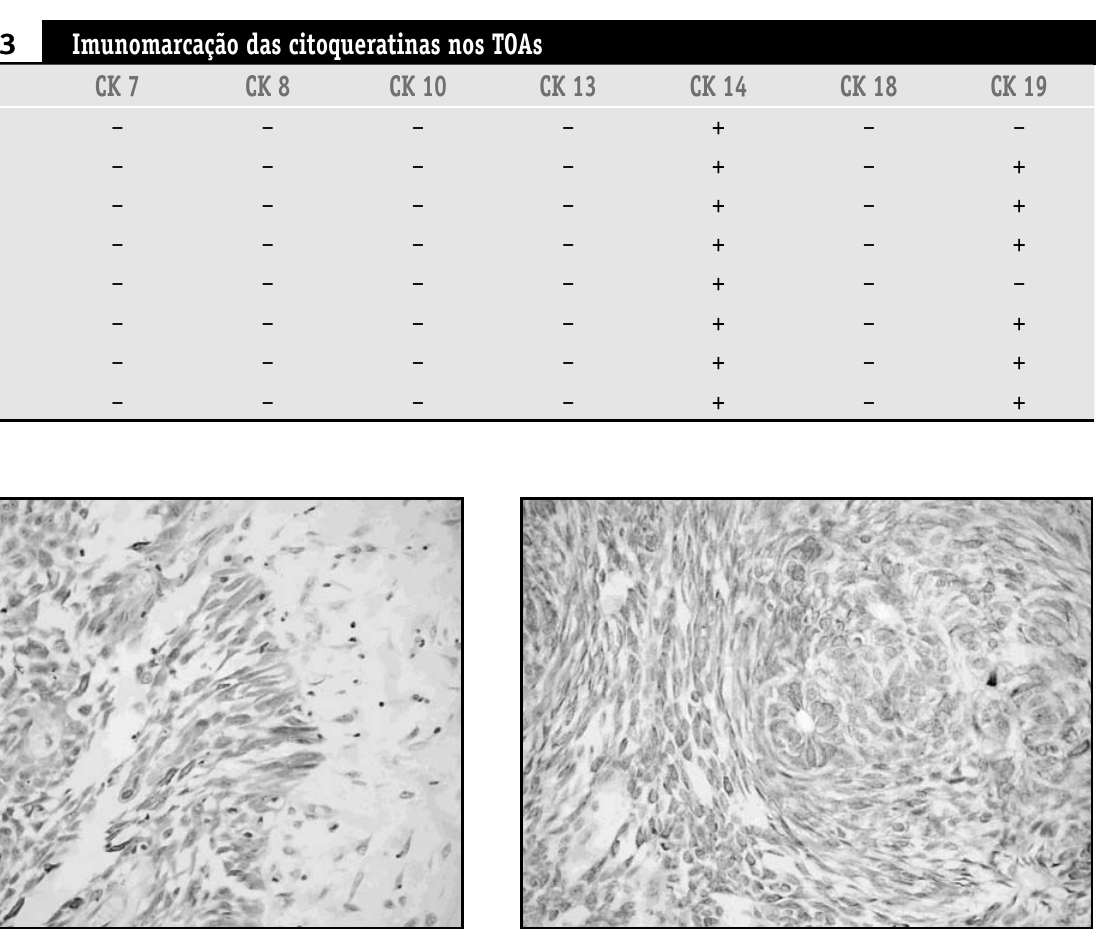
Figura 1 – Ameloblastoma: imunomarcação para CK 14 nas células da periferia dos ninhos tumorais (SABC, 200x)